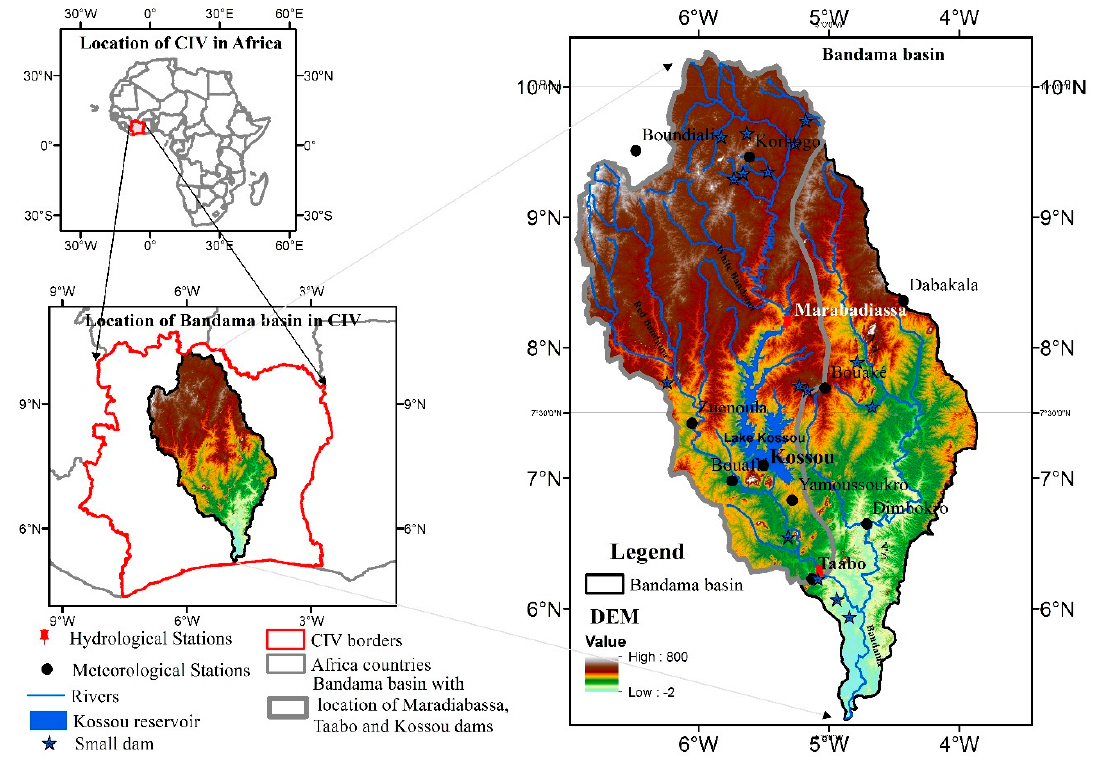
Figure 1. Location of Bandama basin.